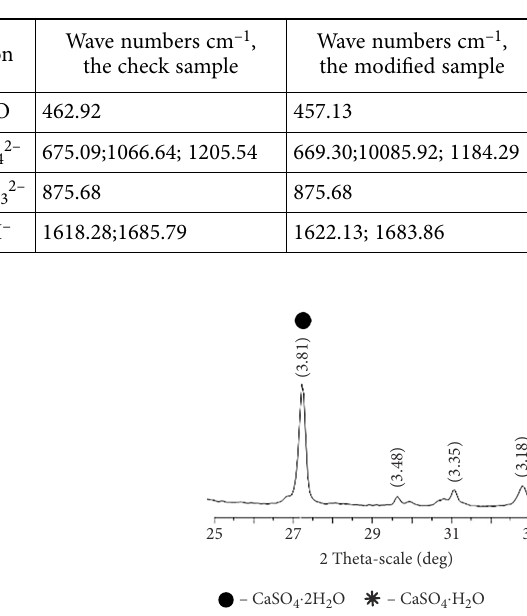
Figure 7. Comparison of the results of X-ray phase analysis of the check and modified